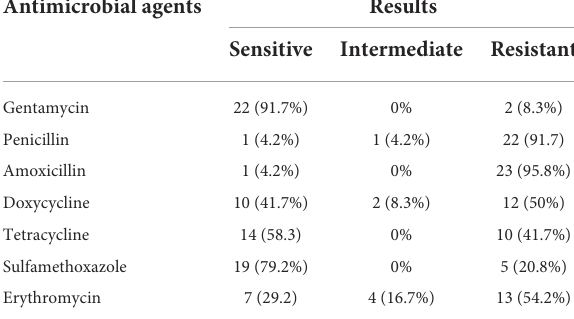
TABLE 3 In vitro antimicrobial drug susceptibility results of E. coli isolates. Antimicrobial